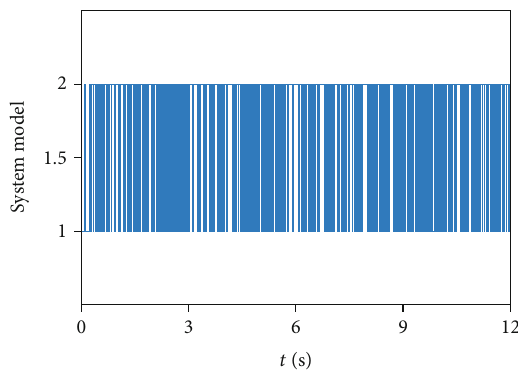
Figure 2: Switching of system